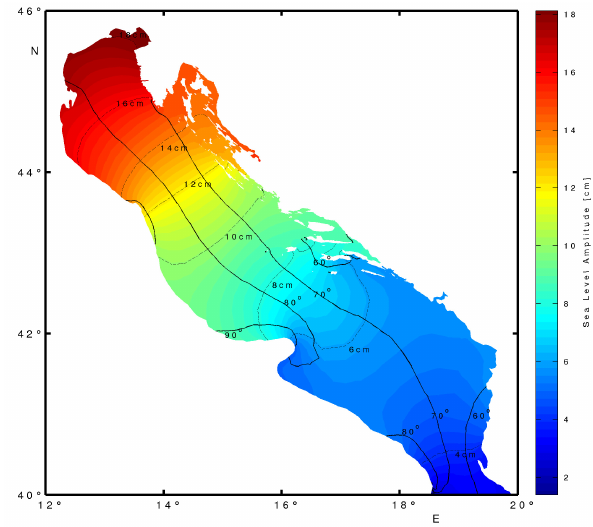
Fig. 6. Co-amplitude and co-phase chart for K1 tidal constituent. Amplitudes are in cm (thin dashed line with 2-cm increment) and phases (line with 10 ◦ increment) in degrees relative to 15 ◦